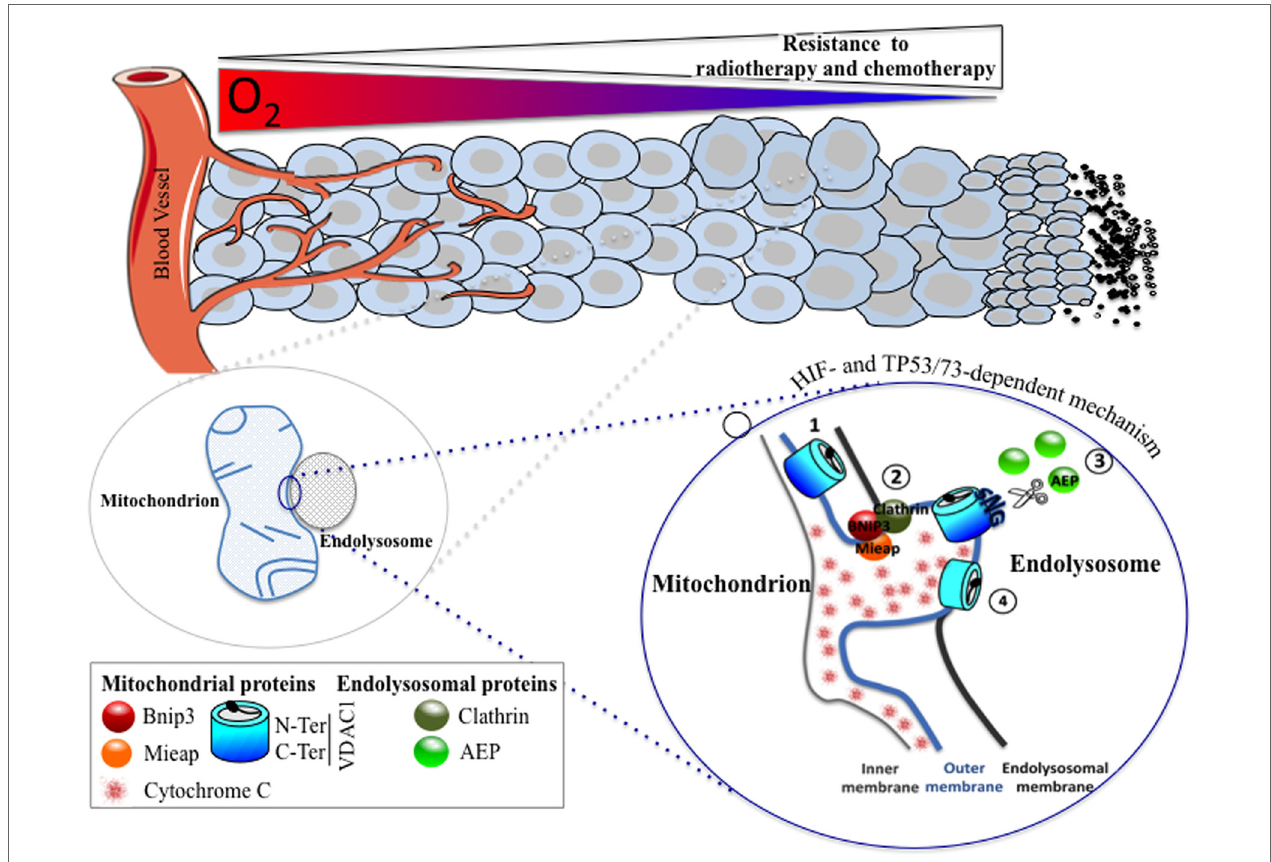
FiGURe 1 | A HiF- and TP53/73-dependent model that potentiates tumor cell survival in hypoxia through the formation of enlarged mitochondria that interact with endolysosomes to modify mitochondrial vDAC1, an ATP channel-regulating metabolism and apoptosis . As oxygen diffuses from a vessel, a decreasing gradient in the oxygen concentration occurs in the adjacent tissue (top). As the level in oxygen decreases, resistance to radiotherapy and chemotherapy increases since the former requires oxygen for DNA damage, and the latter depends on the limits of tissue diffusion of the drug. Hypoxic cells with resistance to chemotherapy show the presence of enlarged hypoxic mitochondria (magnified on the bottom left). Microfusion between the mitochondrial outer membrane and an endolysosomal membrane takes place (magnified on the bottom right), and a cleaved form of VDAC1 is produced, according to the following steps: (1) VDAC1 is exposed to an endolysosome, (2) a complex formed of BNIP3/Mieap (mitochondrial proteins) and clathrin (endolysosomal protein) maintained microfusion of both membranes, (3) the endolysosomal asparagine endopeptidase (AEP), in contact with the mitochondrial outer membrane, specifically cleaves VDAC1, and (4) VDAC1- Δ C promotes resistance to apoptosis and a blockade in cytochrome c